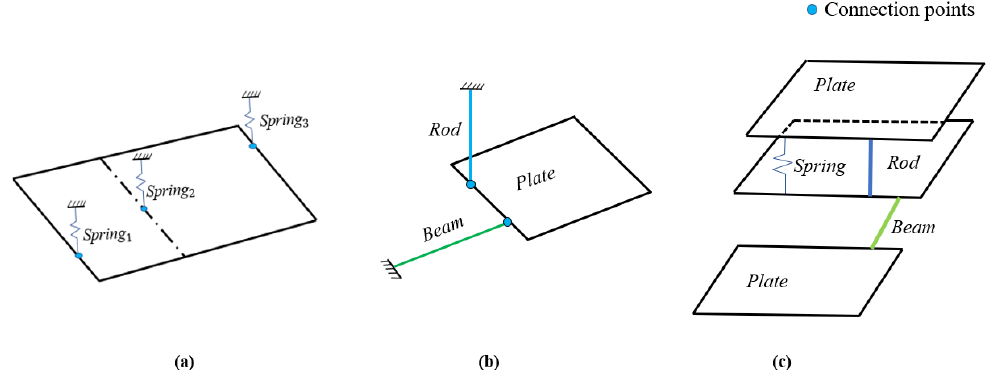
Figure 7. Parent structure with lines nodes connected to point supports/connections without slave degrees of freedom: ( a ) A plate connected to three springs; ( b ) A plate connected to a rod and a beam; ( c ) Plates coupled by a spring/rod/beam.